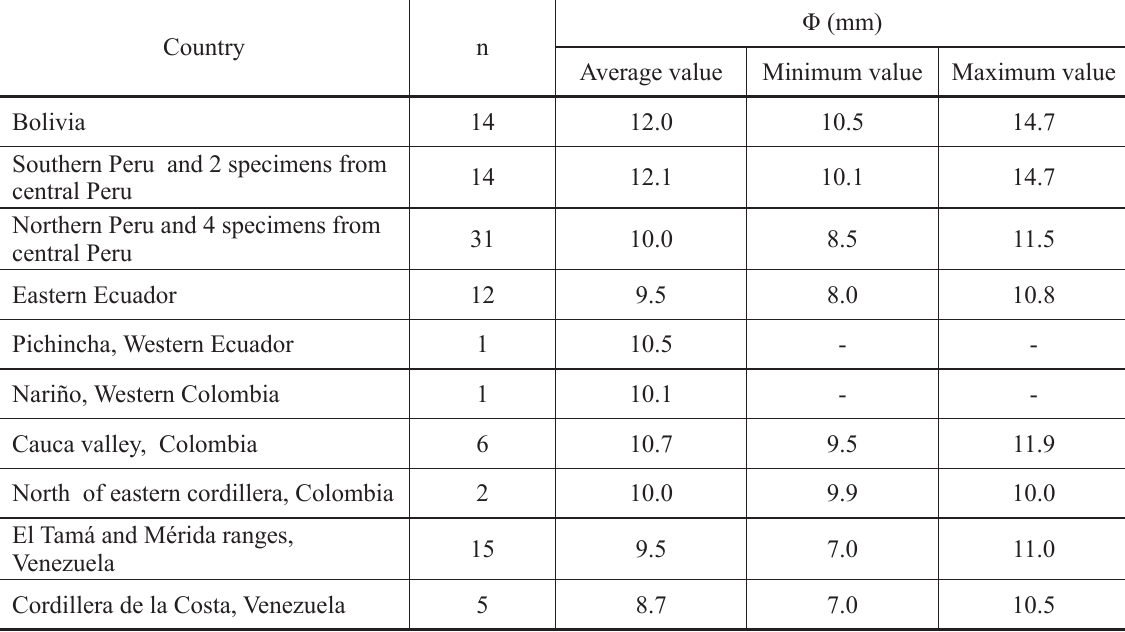
Table 5. Variations of the larger diameter (Φ) of the Cu1-Cu2 ocellus on male ventral hindwing. (n = number of individuals on which measurements have been made, directly or on scaled